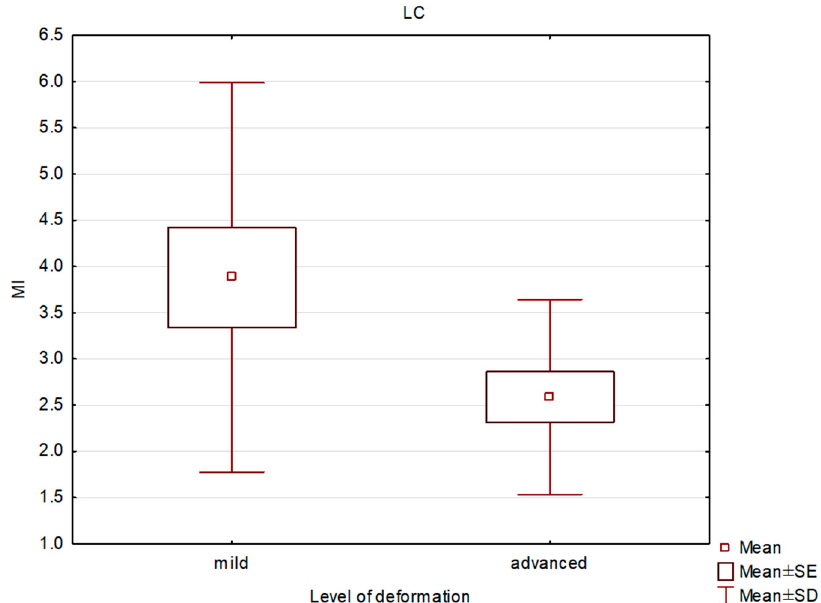
Figure 12. Box and whisker plot of the mineralization index (MI) in patients with mild and severe deformities in the lateral condyle (LC).